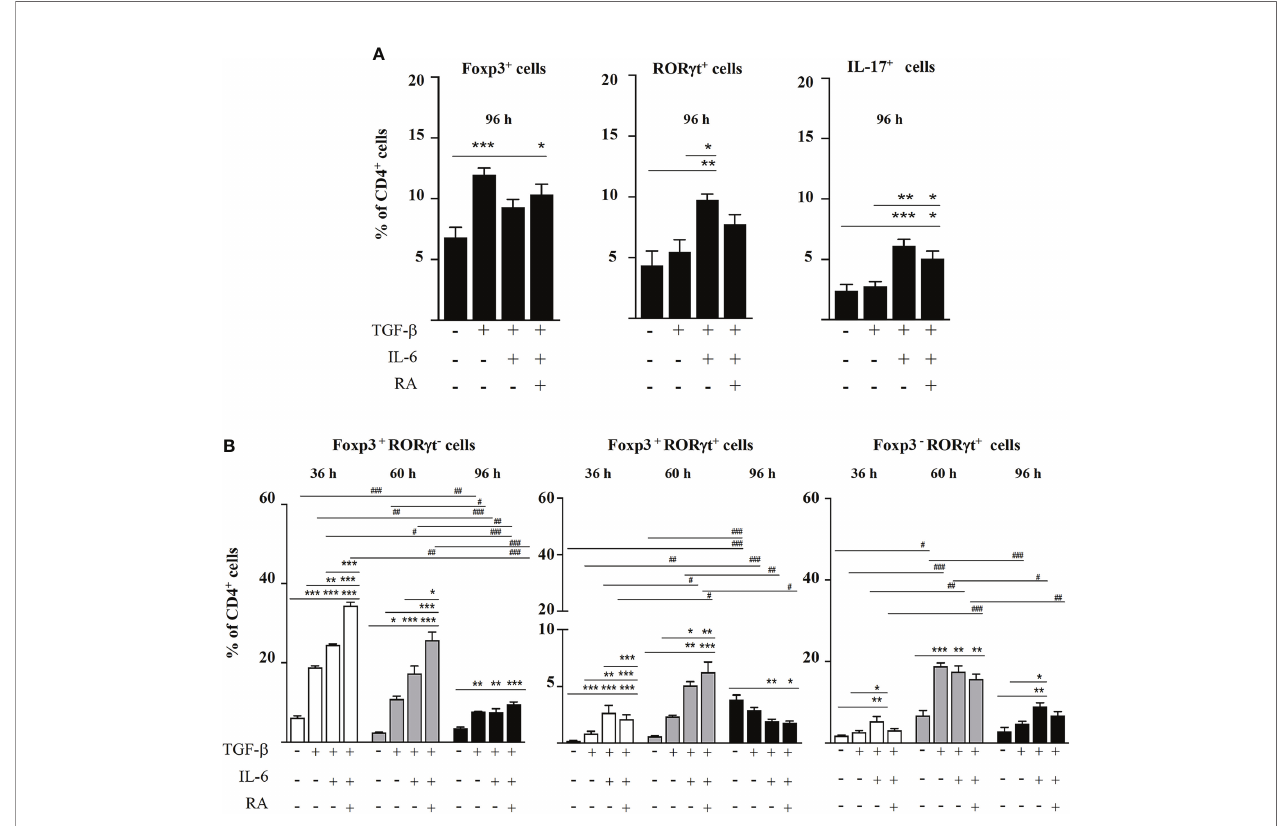
FIGURE 1 | Magnetic sorted CD4 + CD25 - spleen cells from BALB/c mice were stimulated with plate-bound anti-CD3 and soluble anti-CD28 in the presence of IL-2 (20 ng mL -1 ) and combinations of TGF- b (5 ng mL -1 ), IL-6 (20 ng mL -1 ), and RA (0.1 m M). (A) Percentage of Foxp3 + , ROR g t + , and IL-17 + cells within the total CD4 + T cell population after 96 h of culture. (B) Percentage of Foxp3 + ROR g t - , Foxp3 + ROR g t + , and Foxp3 - ROR g t + T cells at different time points. Data are means of three different experiments (each performed with cells sorted from polled spleens from 3-5 mice) ± SEM (n= 3). * P < 0.05, ** P < 0.01, *** P < 0.001 indicate statistically signi fi cant differences between culture conditions at each time point assessed by one-way ANOVA followed by Tukey post-hoc test, and # P < 0.05, ## P < 0.01, ### P < 0.001 indicate statistically signi fi cant differences between time points for each culture condition assessed by two-way ANOVA followed by Tukey post-hoc